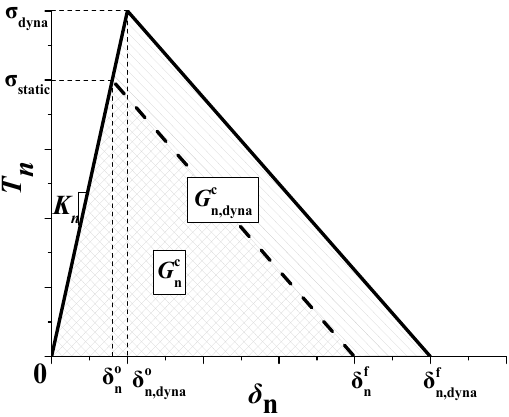
Figure 2. Rate-dependent traction–separation law in normal direction.